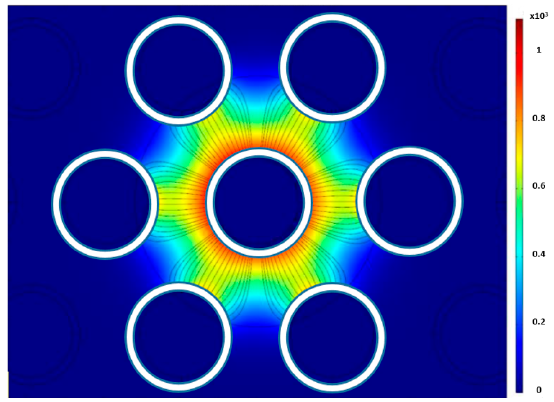
Figure 10. Electric field contour for the case with no air bubbles.